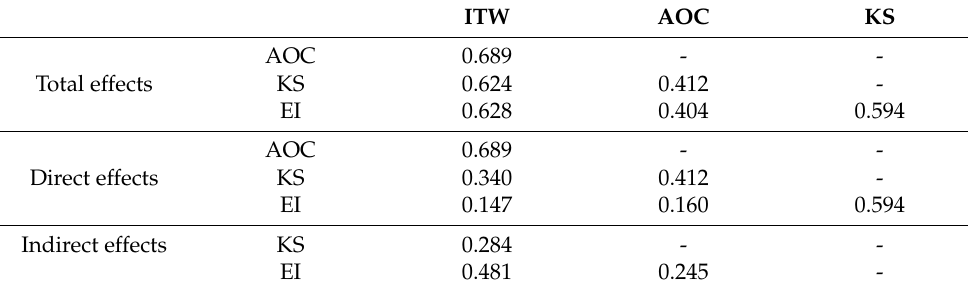
Table 4. Standardized coefficients of the structural effects on IB.